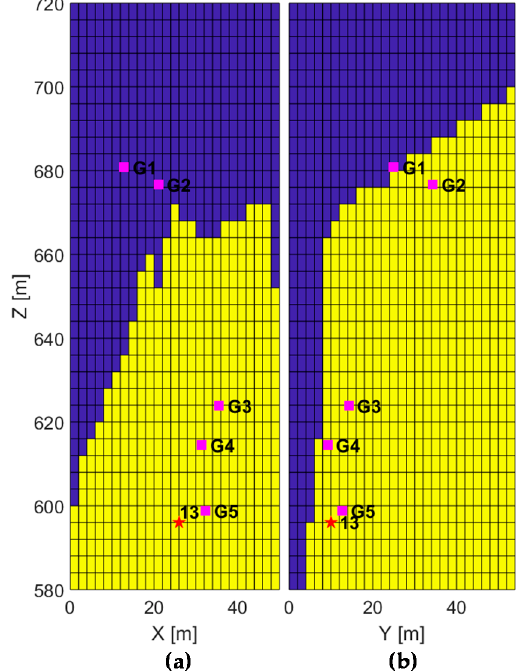
Figure 15. Location results for Fracture event 13 (Suspected fracture) presented on vertical slices in the front view ( a ) and the side view ( b ). The blue area is the air, and the yellow area is rock mass. Pink squares indicate the five 3C geophones projected on the slice. Red stars indicate the event locations projected on the slice.